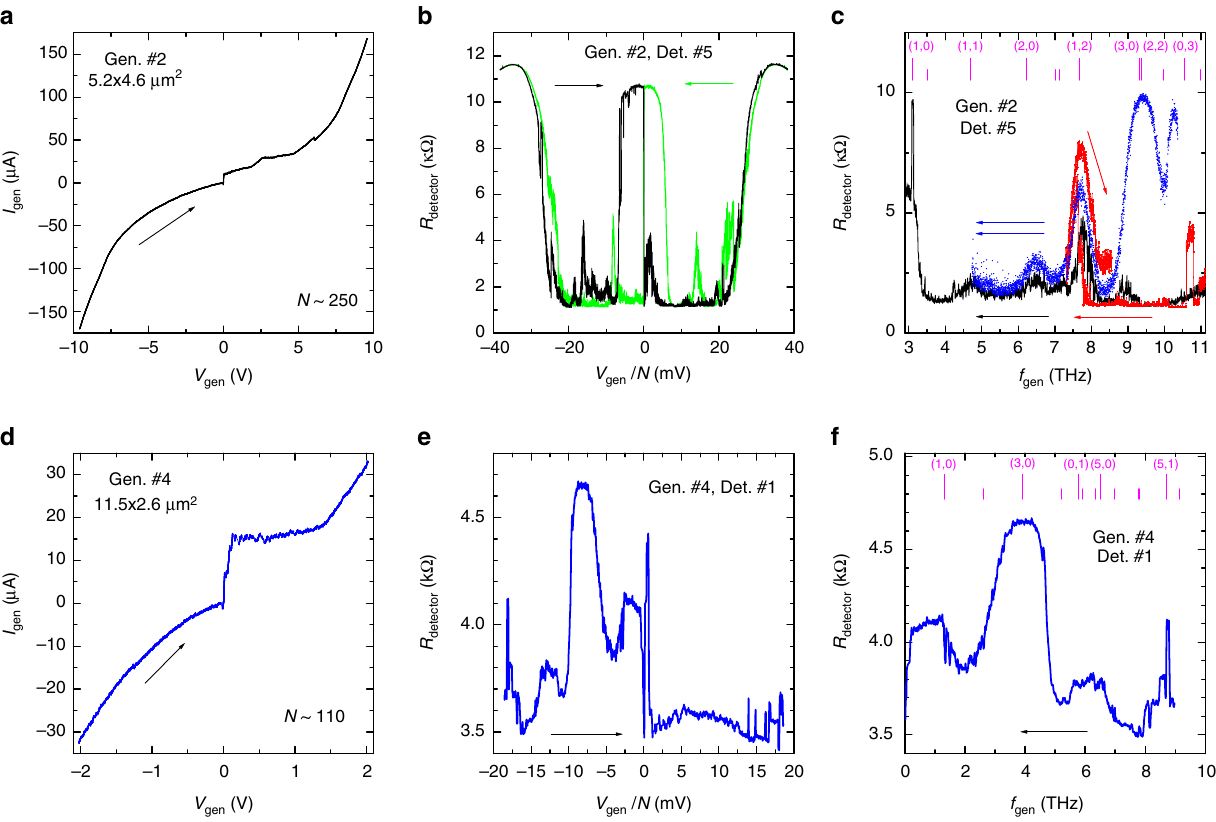
Fig. 3 Generation detection experiment. For a – c generator #2, detector #5 and d – f generator #4, detector #1. The base temperature is T = 3 K. a , d I – V characteristics of generator mesas for bias sweep from negative to positive voltage. b , e Measured detector responses as a function of the detector voltage per junction. The green line in b represents detector response for a reverse bias sweep in the generator from positive to negative voltage. c , f Emission spectra: detector response vs. Josephson frequency for the falling parts of the generator I – V curves. Different colors in c represent different sweeps. Arrows indicate sweeping directions. Bars at the top indicate expected positions of primary cavity